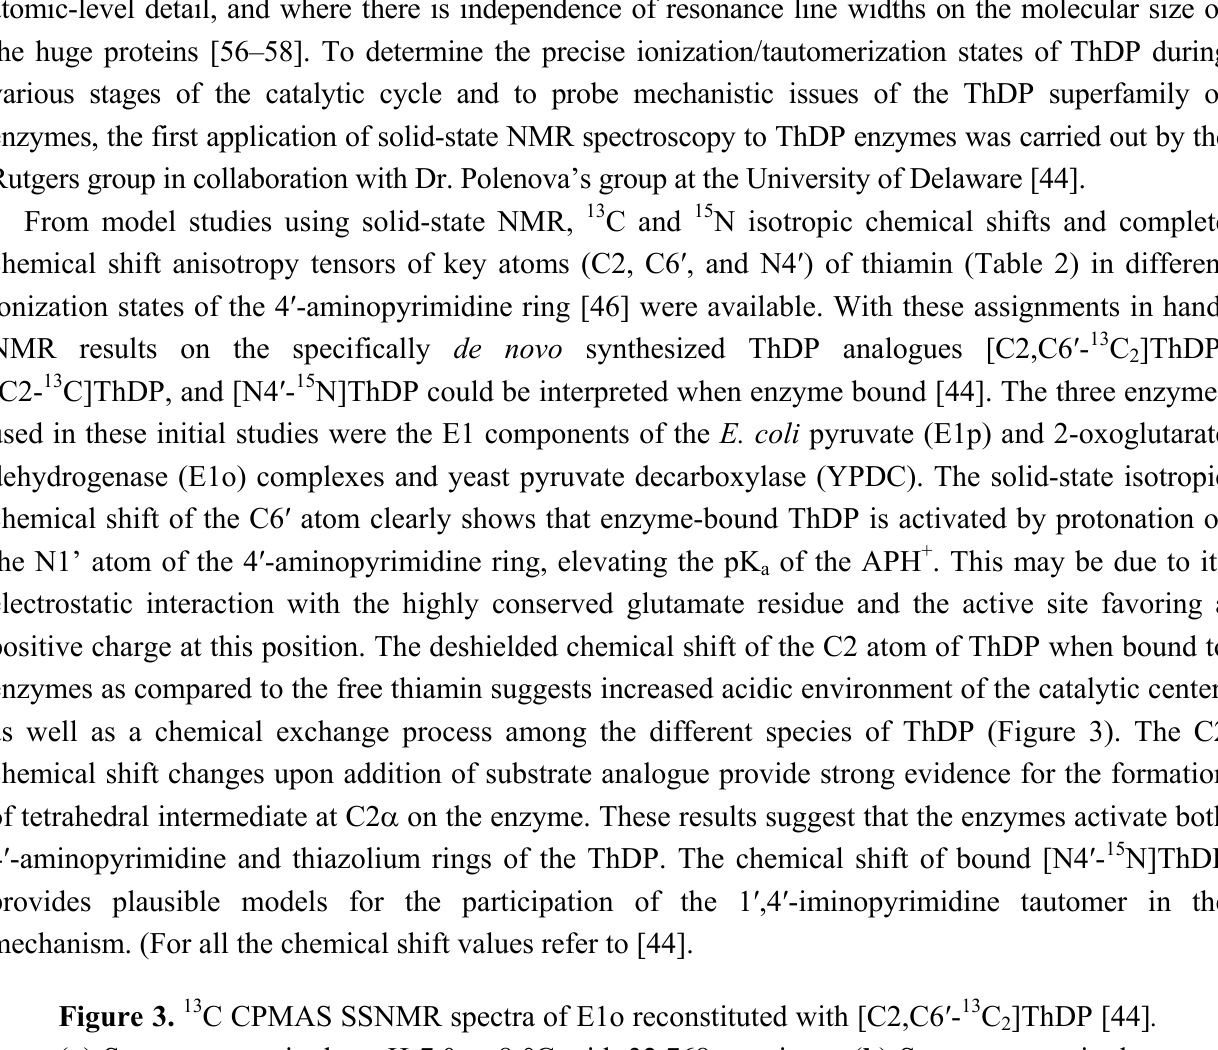
]ThDP [44] . 2 PO , and 15 mM Tris) 2 4